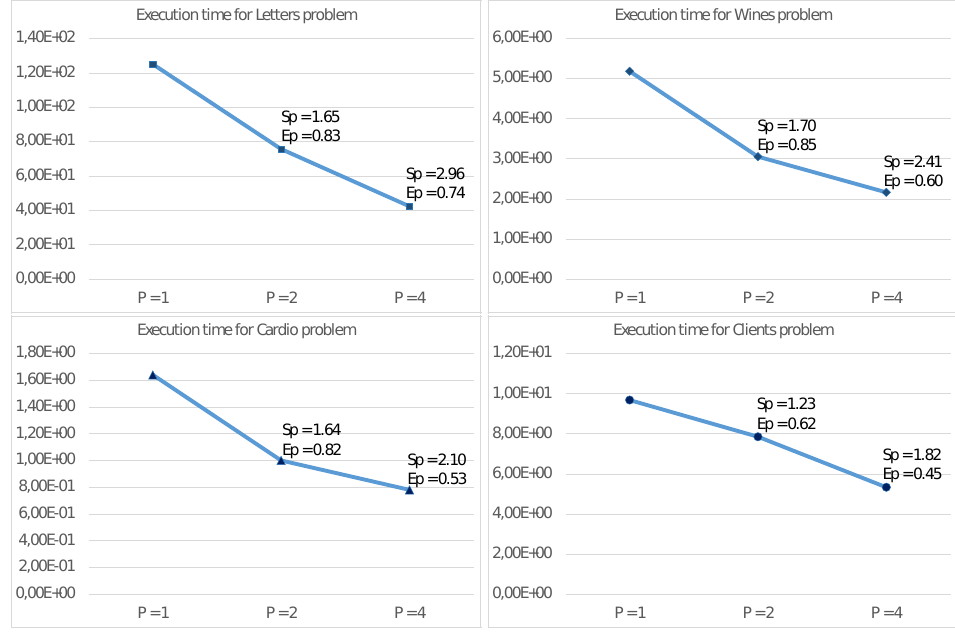
Figure 3. Execution time (in seconds), Speed-up and Efficiency of Algorithm 2 on the UDOO X86 Advanced+ board.